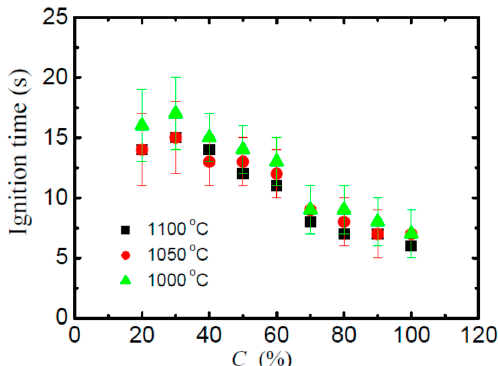
Figure 5. The ignition time as a function of the oxygen partial pressure ( C o ) for the Ti14 alloy as obtained from the forging temperature of 1000, 1050, and 1100 °C. The results are averaged over five burning tests. It is noticed that, to reduce the effect of heating times, a preheating process is provided to